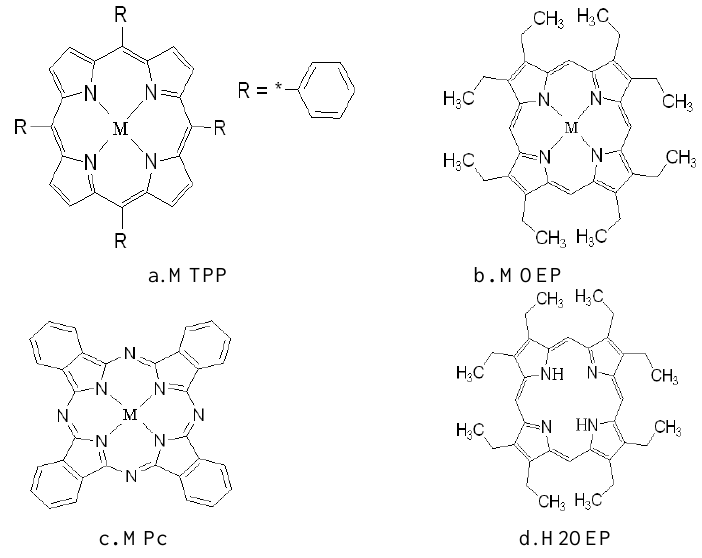
Figure 1. The molecular structures of the chemically sensitive